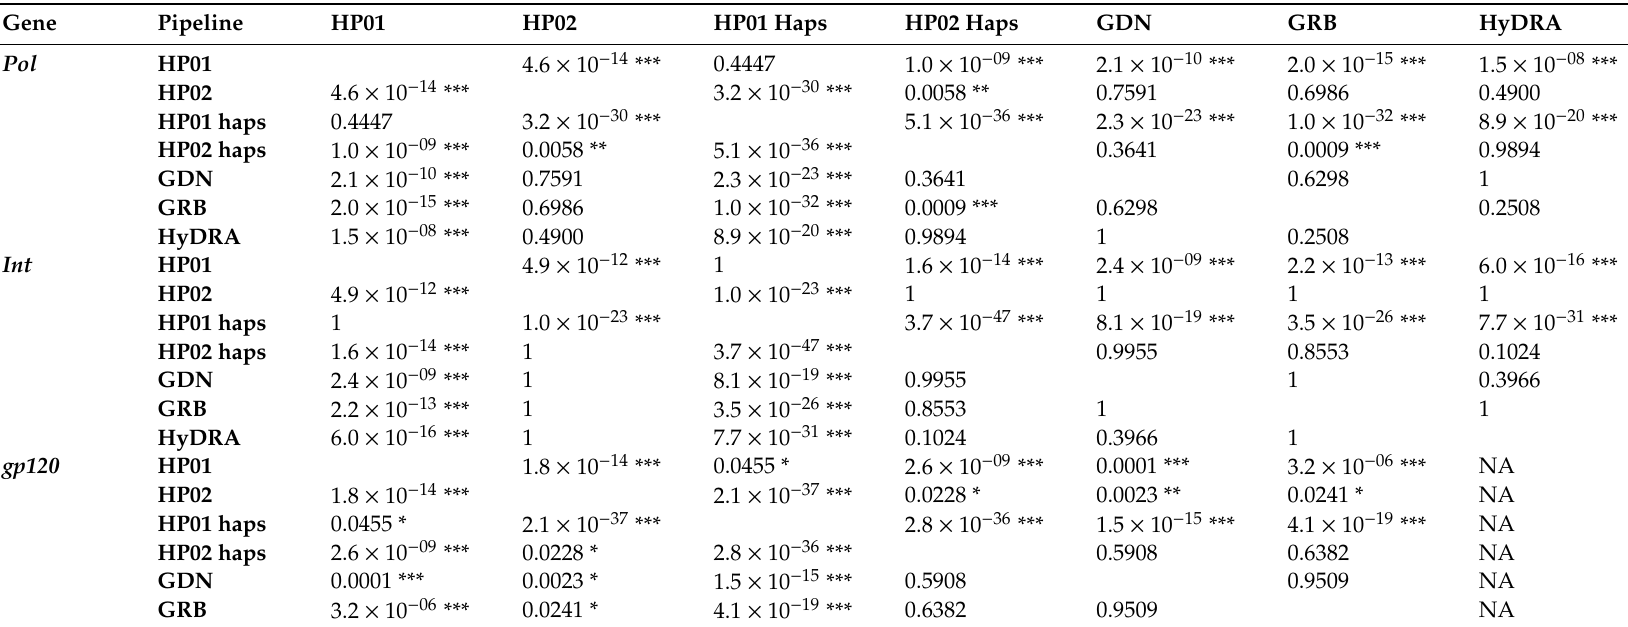
Table A7. Kruskal–Wallis multiple comparisons (Dunn test) of the adjusted genetic p-distance of the pipeline consensus sequence from HXB2, the HIV reference sequence, for the HIV empirical dataset. Adjusted p -values are reported (Holm